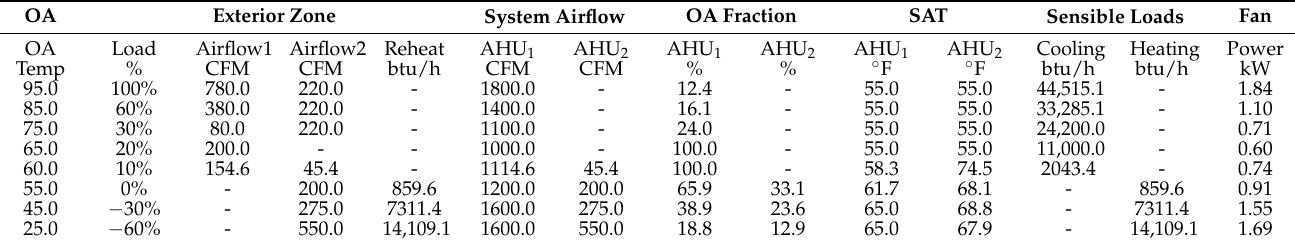
Table 3. Calculations for Dual VAV